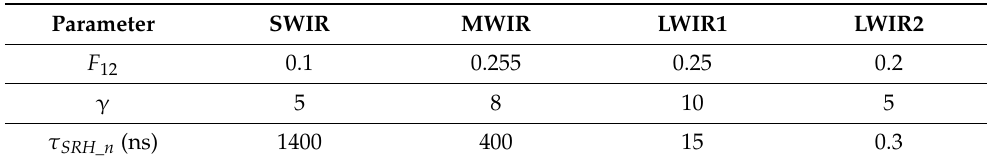
Table 2. HgCdTe material parameters at 300 K obtained after fitting simulated and measured I – V characteristics for different spectral ranges.